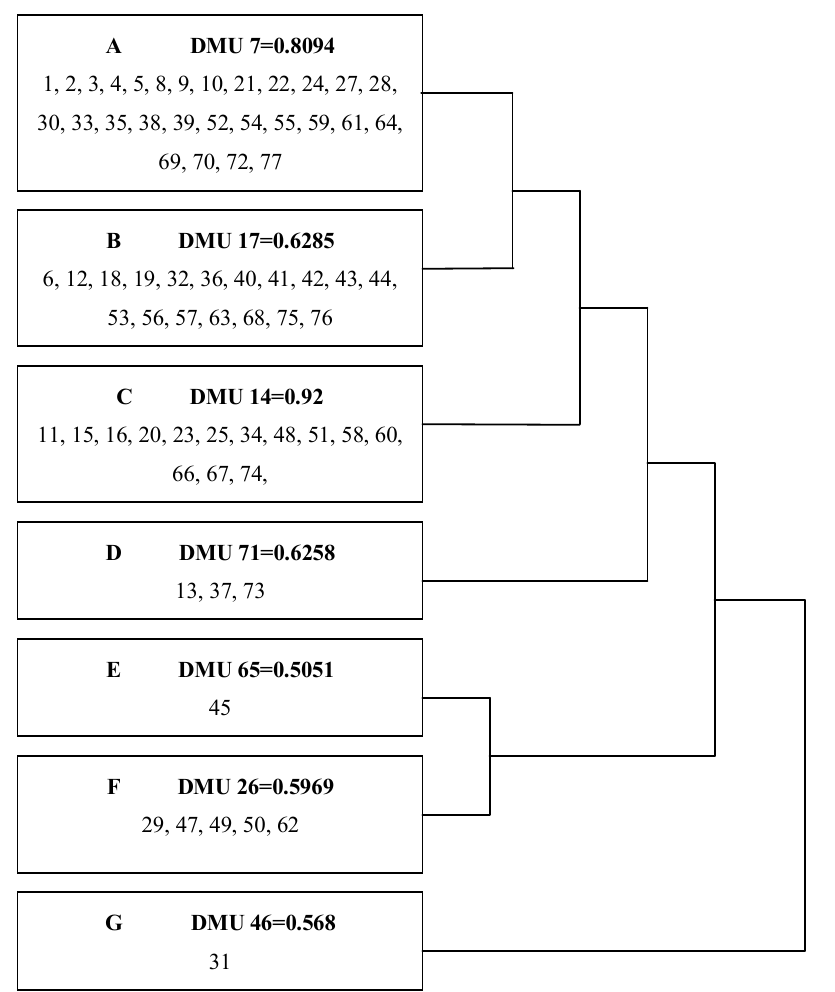
Fig. 1. Clustering result of container ports based on cross